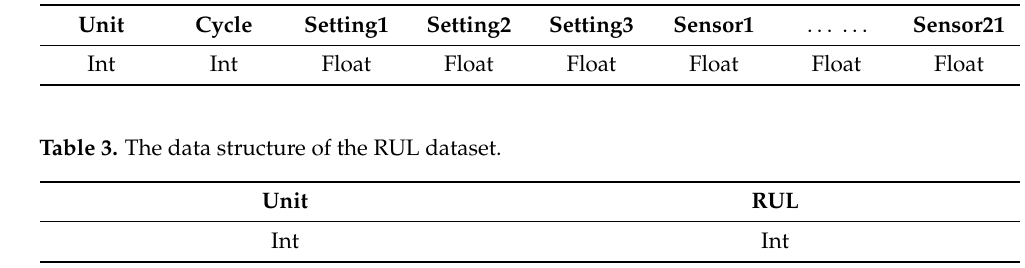
Table 2. The data structures of the training and testing datasets.